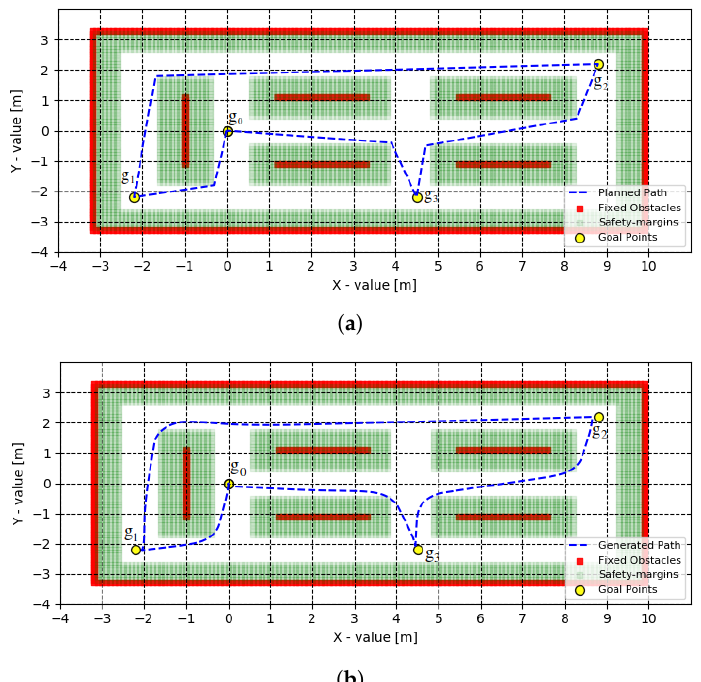
Figure 13. Simulated environment with fixed obstacles: ( a ) planned path using BNM ; ( b ) path executed by the robot.